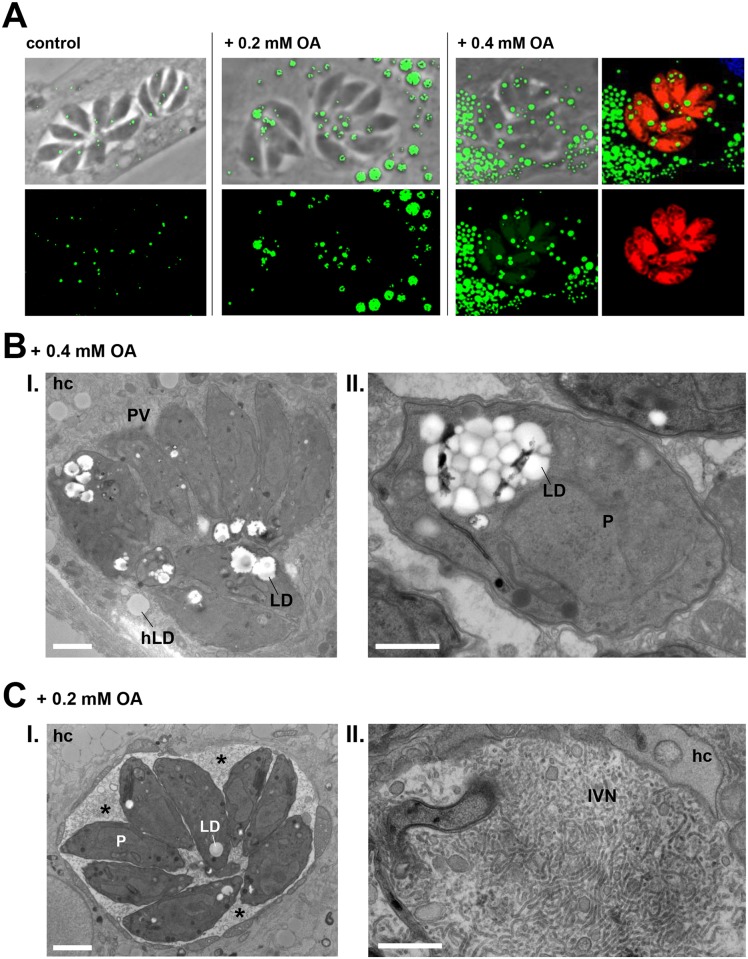
Influence of excess oleate on parasite neutral lipid stores and IVN size.A. Fluorescence microscopy of RFP-expressing Toxoplasma-infected HFF. Infected cells were cultivated without OA (control), or with 0.2 mM OA for 24 h or 0.4 mM OA for 40 h before staining with BODIPY 493/503 (green). Large, fluorescent neutral lipid deposits inside Toxoplasma were observed in the presence of 0.4 mM OA. These deposits are confirmed by the presence of cytoplasmic exclusion zones of the RFP fluorescence in the parasite. B. Transmission EM images of HFF infected for 24 h in the presence of 0.4 mM OA, showing many parasite LD with some as large as host LD (hLD; panel I) and others clustered inside the parasite (panel II). Scale bars, 0.5 μm. C. Transmission EM images of a Toxoplasma PV inside HFF infected for 24 h in the presence of 0.2 mM OA. Panel I (asterisks) shows the expansion of the IVN throughout the vacuolar space, taking up all available space between parasites while panel II shows a magnified view focusing on the abundance of long, intertwined tubules. P, parasite; hc, host cell. Scale bars, 0.3 μm.